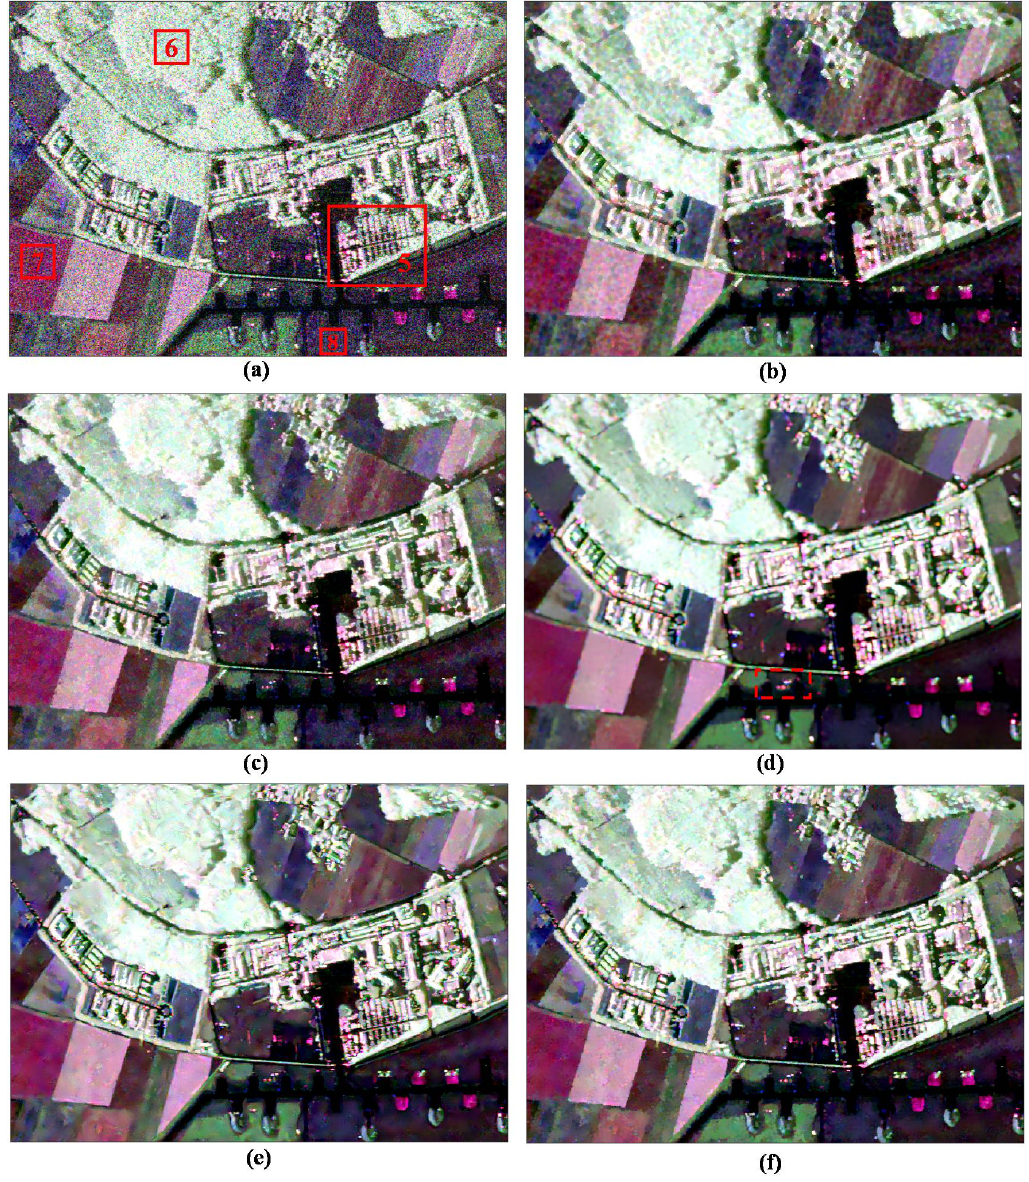
Figure 10. Denoising results of different filtering methods using ESAR L-band data. ( a ) Original data. ( b ) Refined Lee filter. ( c ) IDAN filter. ( d ) Pretest filter. ( e ) NL-SAR filter. ( f ) The proposed ANLM filter.